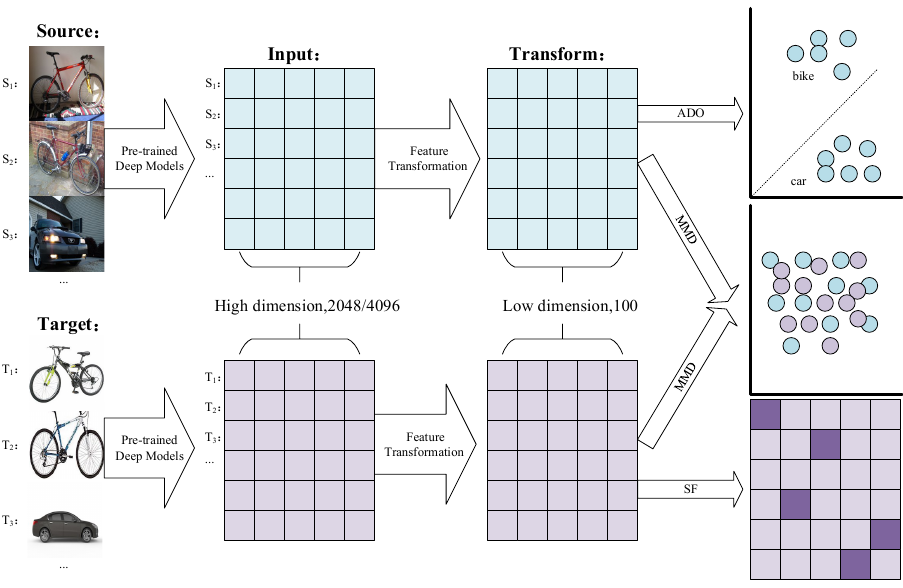
Figure 1. Graphical illustration of the proposed